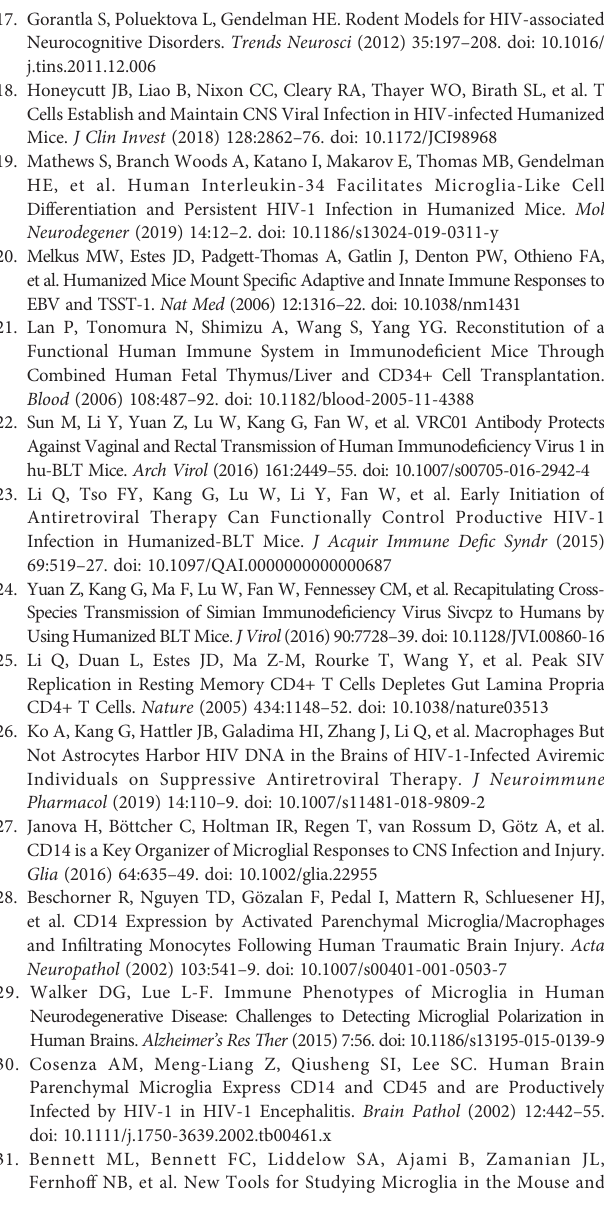
tissues of hu-BLT-hIL-34 and hu-BLT mice. Every upper panel respectively shows human myeloid lineage cells of hIba-1+, hCD14+, hCD68+ or hTMEM119+ were extensivelyreconstituted throughoutthecortex,corpusstriatum,hippocampusand cerebellum of brains of hu-BLT-hIL34 mice; while every lower panel respectively shows an absence of or limited detection of these cells from hu-BLT mice using IHCS. Each ampli fi ed micrograph was shown from the red frame in the left upper corner thumbnails pictures. Scale bar equals 25 m m. Supplementary Figure 3 | The comparison of human meningeal macrophages (MM) and perivascular macrophages (PVM) reconstitutions in the brain tissues of hu-BLT-hIL-34 and hu-BLT mice. The upper panel shows abundant hCD163+ (brown) human parenchymal myeloid cells (A – C) , human meningeal macrophages ( A , arrows) and human perivascular macrophages (C) from representative brain tissue sections of a hu-BLT-hIL34 mice (#1708) detected using IHCS. The lower panel shows an absence of hCd163+ human parenchymal myeloid cells and a few of human meningeal macrophages ( D – F , arrows) of hu-BLT mice